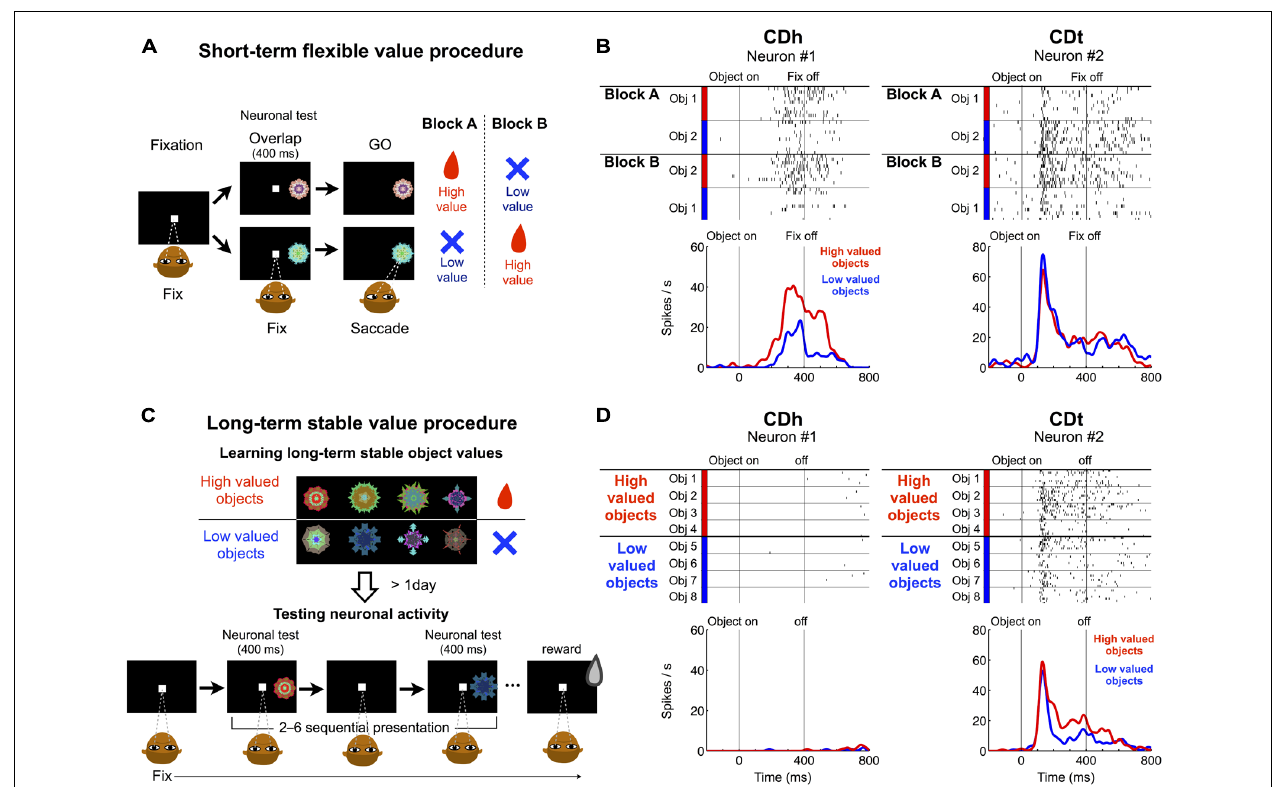
FIGURE 1 | Responses of CDh and CDt neurons to visual objects with flexible and stable values. (A) In the short-term flexible value procedure, each of two fractal objects changed its value frequently across blocks of trials. On each trial one of two objects was presented, to which monkeys made a saccade, which was followed by a liquid reward or no reward. Neuronal recording was done simultaneously. (B) Reponses of one CDh neuron (left) and one CDt neuron (right) in the flexible value procedure.The CDh neuron responded each object more strongly when the object was flexibly high-valued (red) than low-valued (blue; p < 0.05, ranksum test).The CDt neuron responded to the two objects differently, but its response to each object was not affected by the flexible value changes. (C) In the long-term